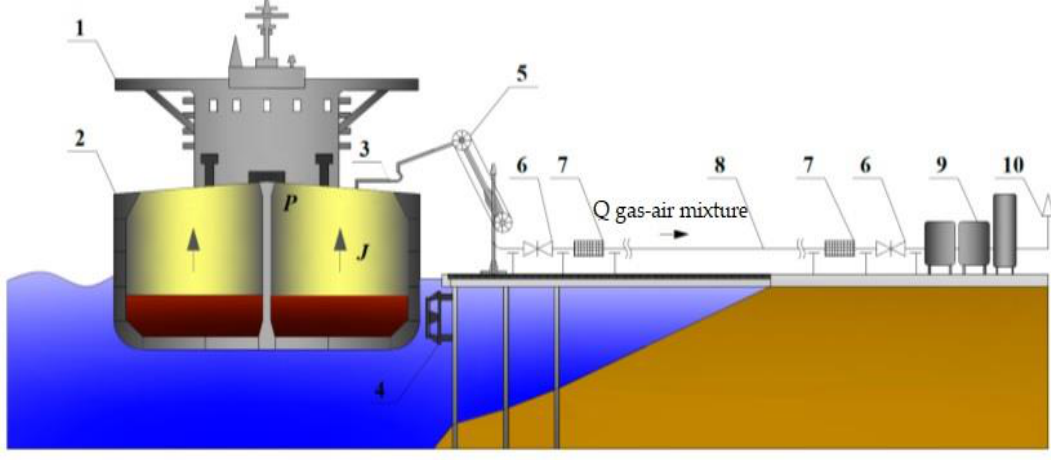
Figure 2. Diagram of hydrocarbon vapors displacement during tanker loading. 1—tanker; 2—double housing; 3—the manifold release of vapor; 4—node protection berthing facilities fender; 5—a stander removal of the gas phase; 6—shut-off and control valves; 7—detonation arrestor; 8—the pipeline of the gas phase; 9—VRU; 10—gas vent.